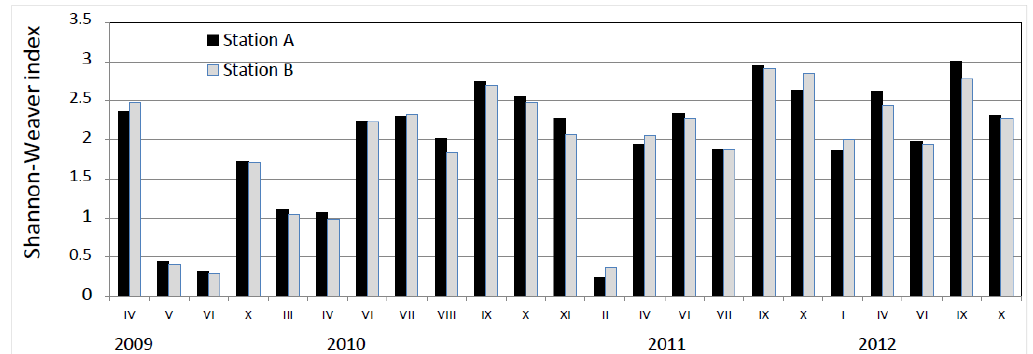
Figure 7. The diversity index of the phytoplankton in the studied period.